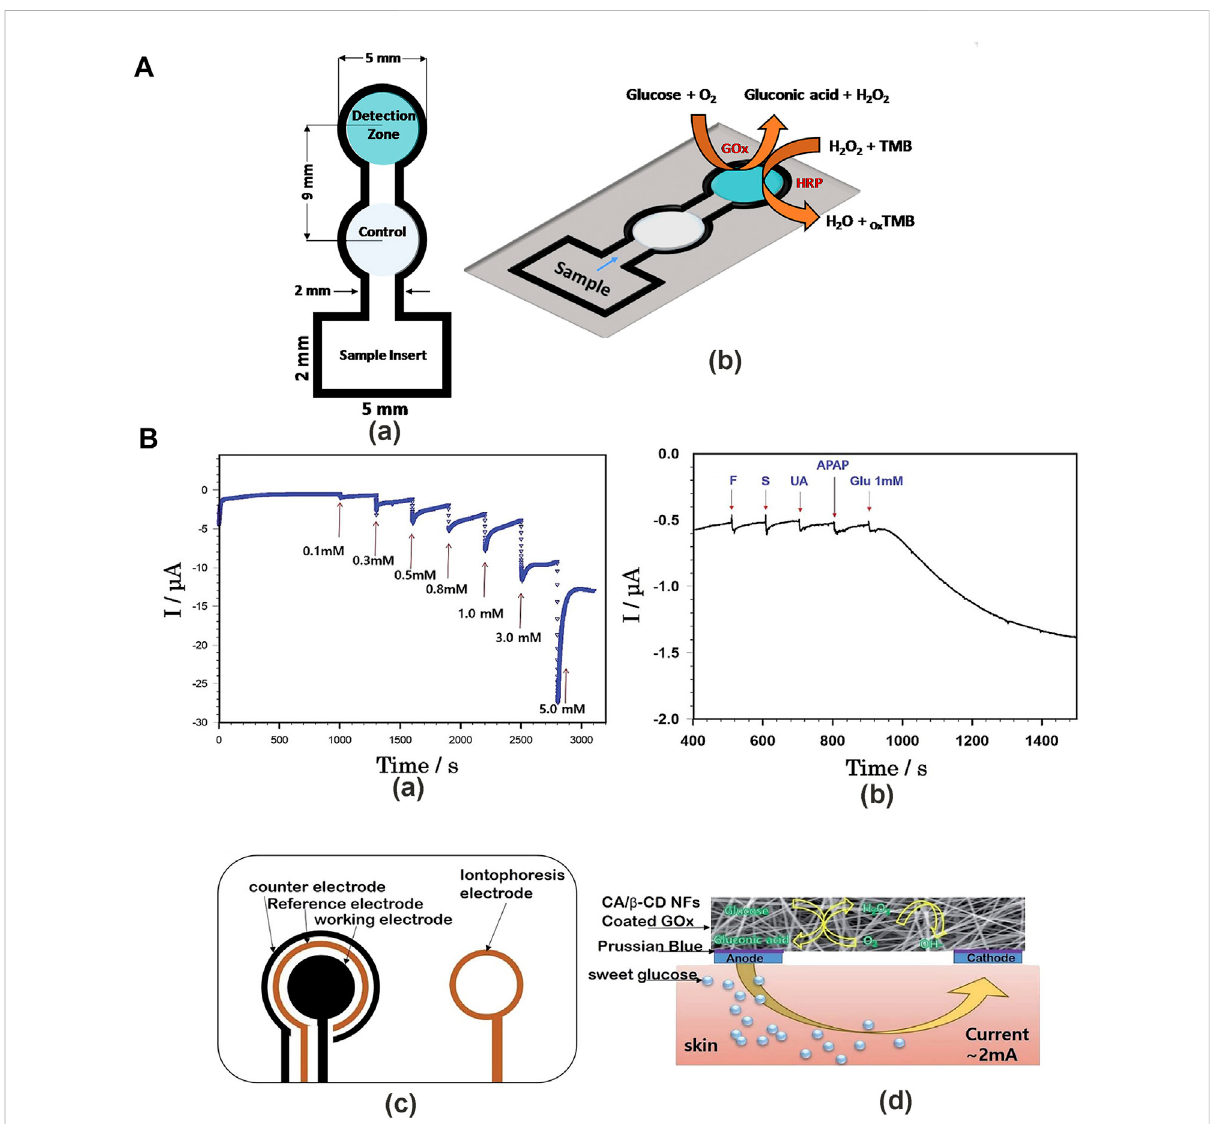
FIGURE 3 Detection methods for a glucose sensor. (A) The CNP-PEG-GOx colorimetric glucose sensor. (a) Colorimetric glucose sensor mold. (b) GlucoselevelsweremeasuredintearsusingTMBasacolorimetricsubstrate(Gabrieletal.,2017). (B) Mechanismofcellulose/ β -CD/GOxNFsglucose sensor. (a) Amperometric responses of glucose in PBS at − 0.2 V. (b) The effect of interfering substances on measuring glucose levels. (c) Schematic illustration of iontophoresis printable electrodes, counter, reference, and working electrode for glucose sensors. (d) Mechanism